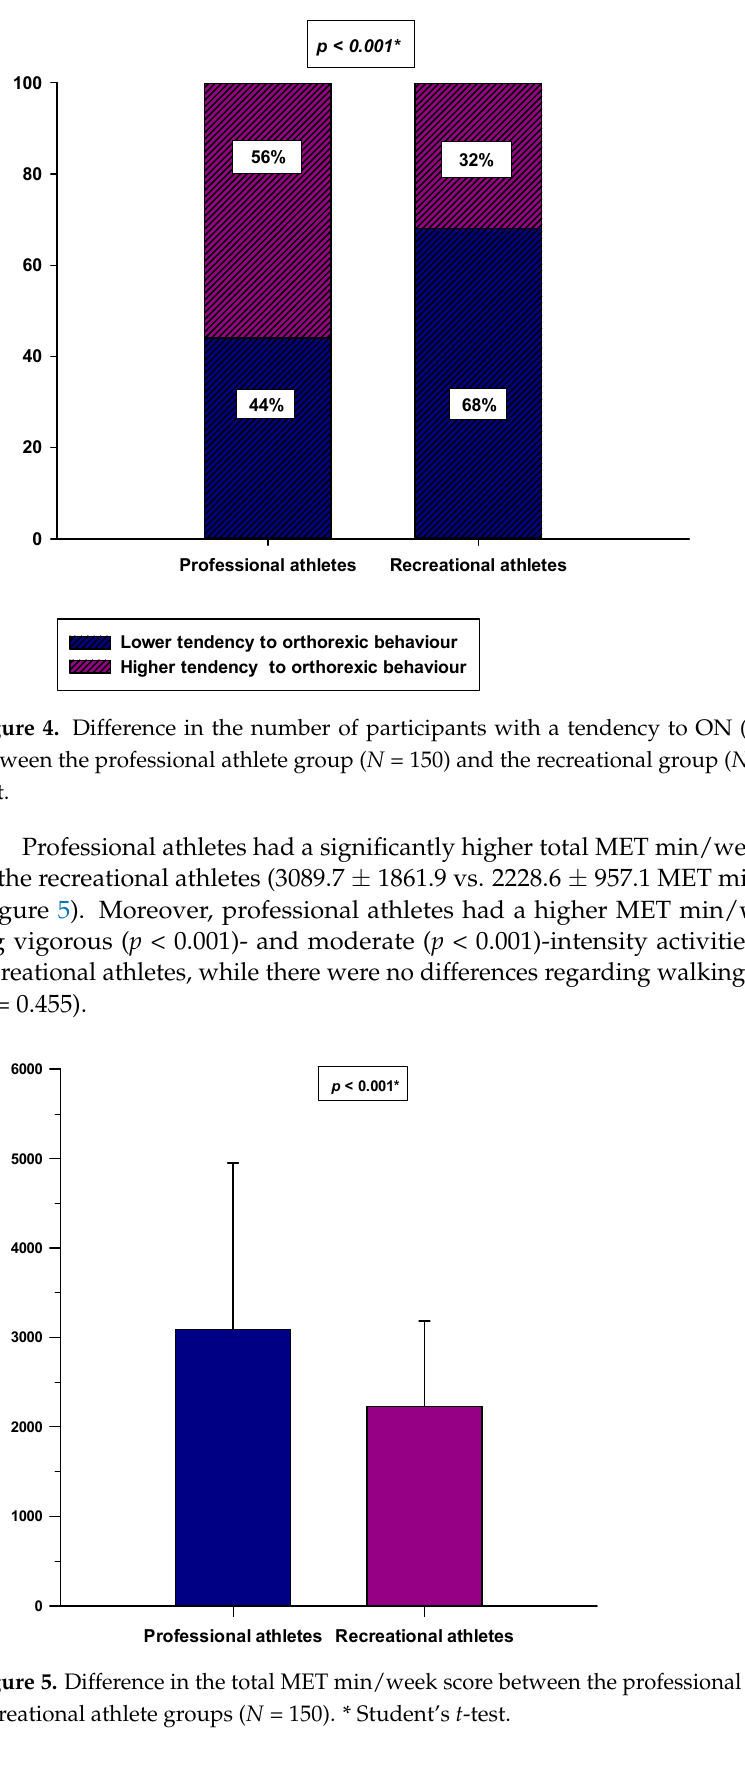
Figure 3. Difference in the ORTO-15 score between the professional athlete ( N = 150) and recreational athlete groups ( N = 150). * Mann–Whitney U test.